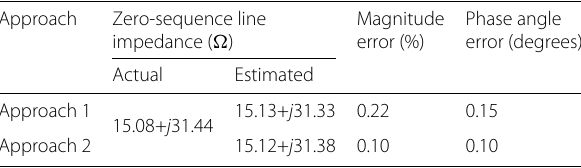
Table 2 Estimated vs. Actual Zero-sequence Line Impedance